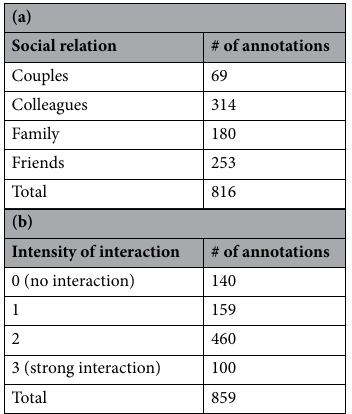
Table 1. Number of groups annotated with each (a) social relation (in ATC data set) and (b) intensity of interaction (in DIAMOR data set).